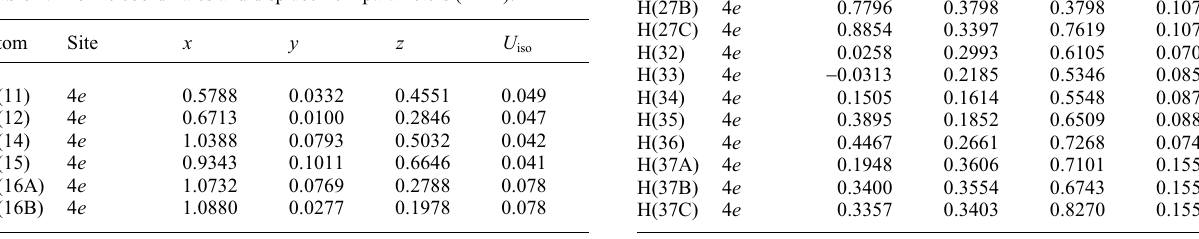
Table 2. Atomic coordinates and displacement parameters (in Å 2 ) .